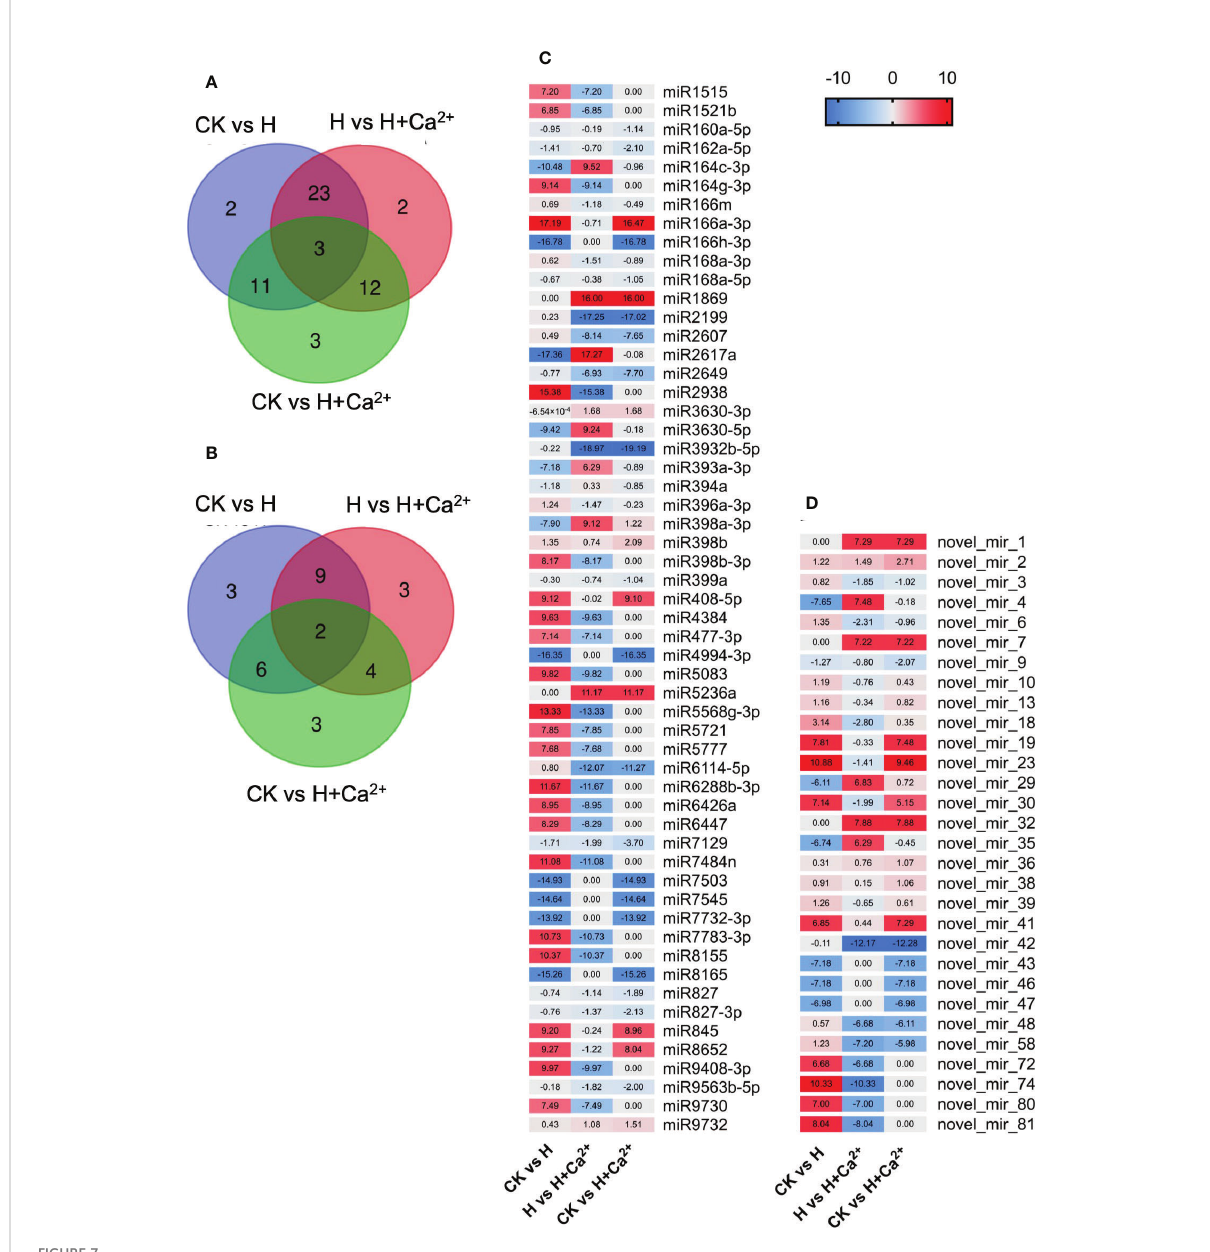
FIGURE 7 Analysis of differentially expressed miRNAs of cucumber under hypoxia and hypoxia + CaCl 2 exogenous calcium treatment. (A) Venn diagrams for analysis of know miRNAs differentially expressed in the CK vs H, H vs H + Ca 2+ and CK vs H + Ca 2+ comparison. (B) Venn diagrams for analysis of novel miRNAs differentially expressed in the CK vs H, H vs H + Ca 2+ and CK vs H + Ca 2+ comparison. (C) Heatmap of differentially expressed known miRNAs. (D) Heatmap of differentially expressed novel miRNAs. The names of miRNA are shown in brackets. Blue indicates relatively low expression; red indicates relatively high expression. The heatmap relative value were calculate by log2 fold changes (CK/H), log2 fold changes (H/H + Ca 2+ ) and log2 fold changes (CK/H + Ca 2+ ),